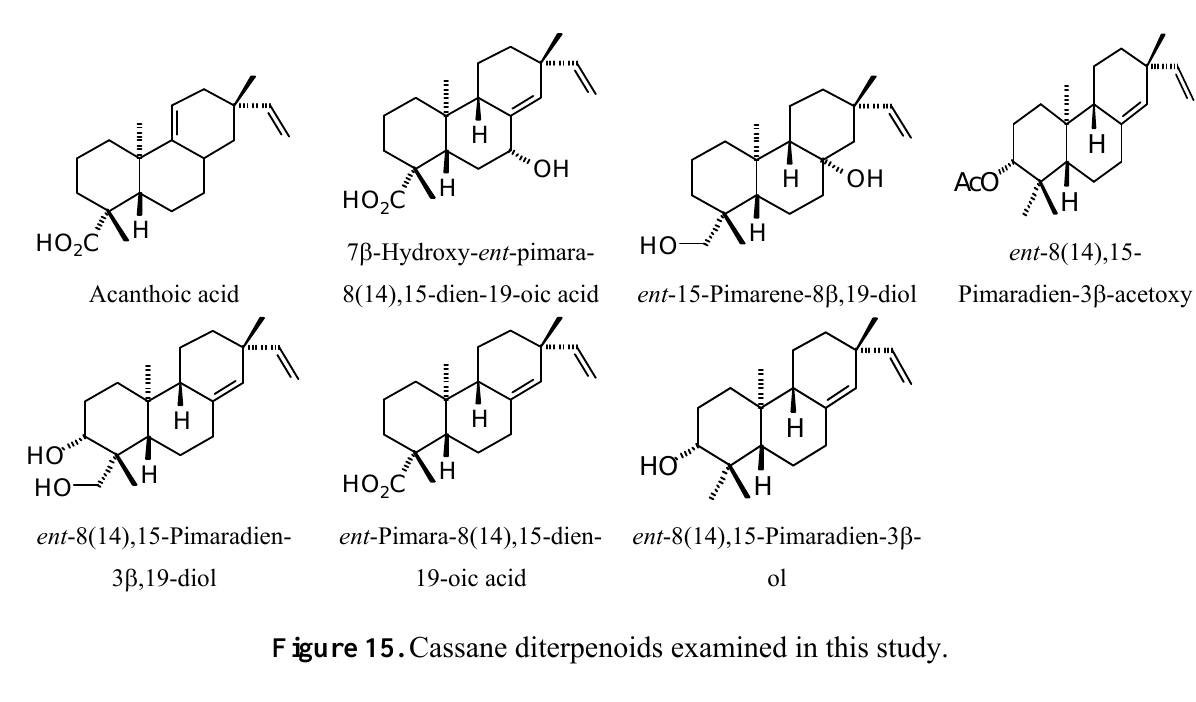
Figure 14. Pimarane diterpenoids examined in this study.